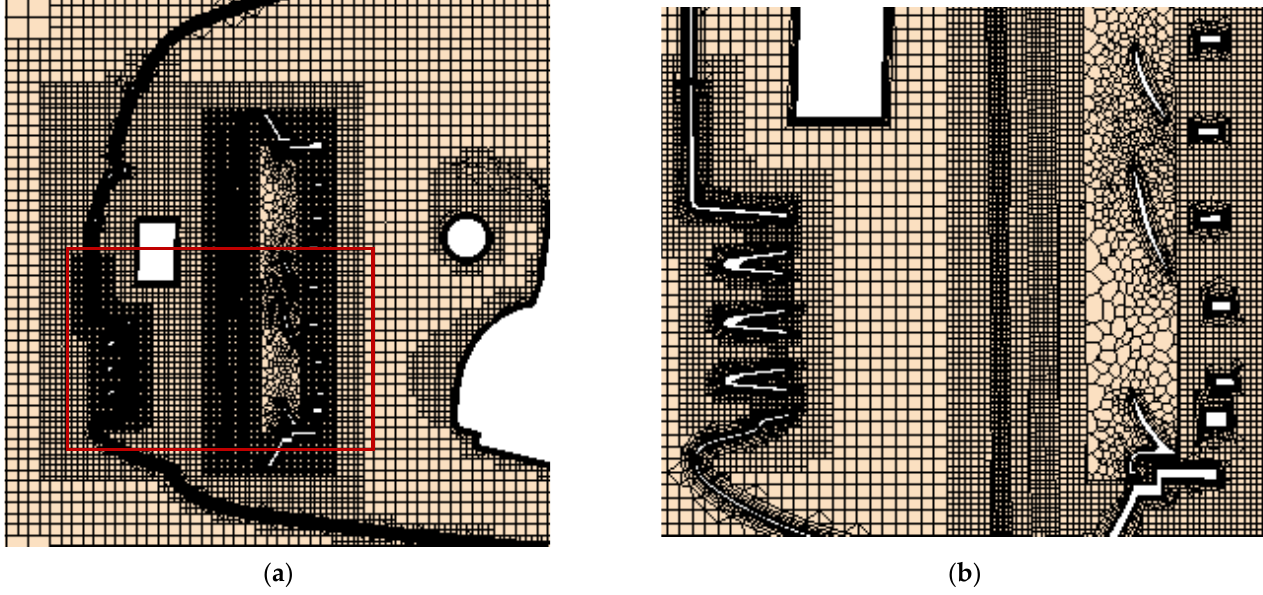
Figure 2. Volume mesh division of the engine compartment: ( a ) engine compartment at the y = 0 m section; ( b ) the enlarged part in the red box. section; ( b ) the enlarged part in the red